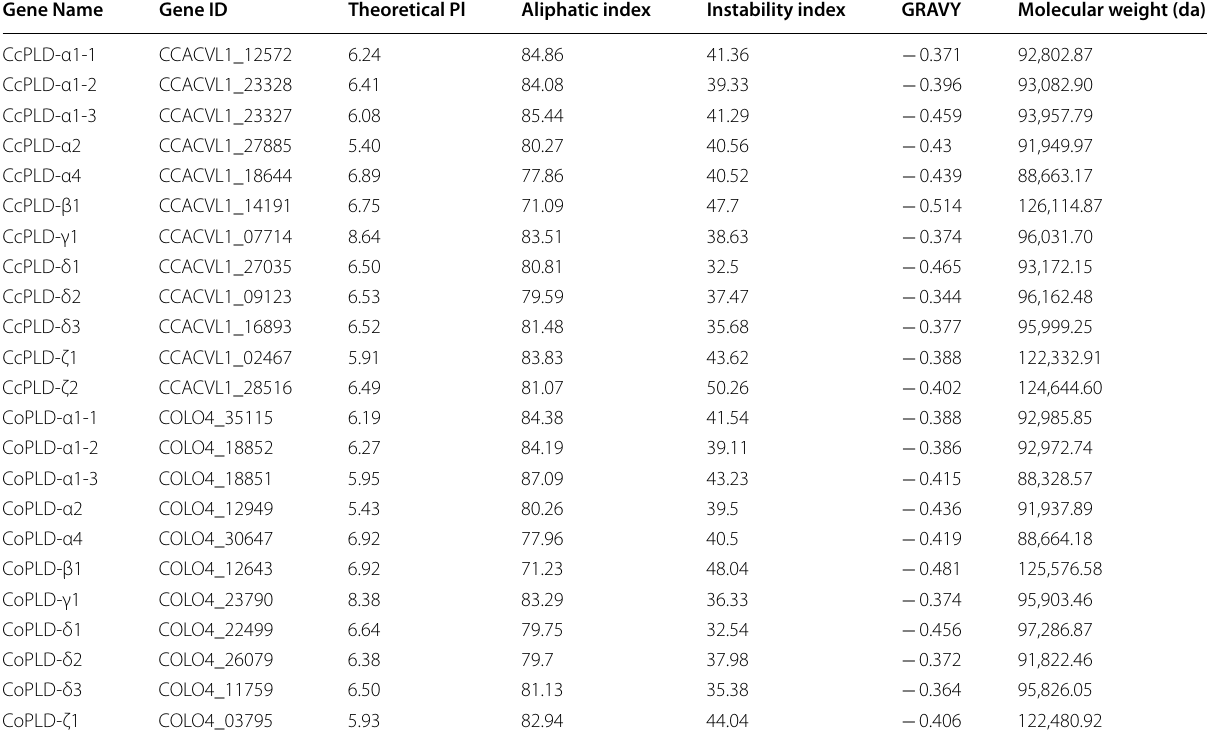
Table 2 List of identified PLD genes along with several physical and chemical